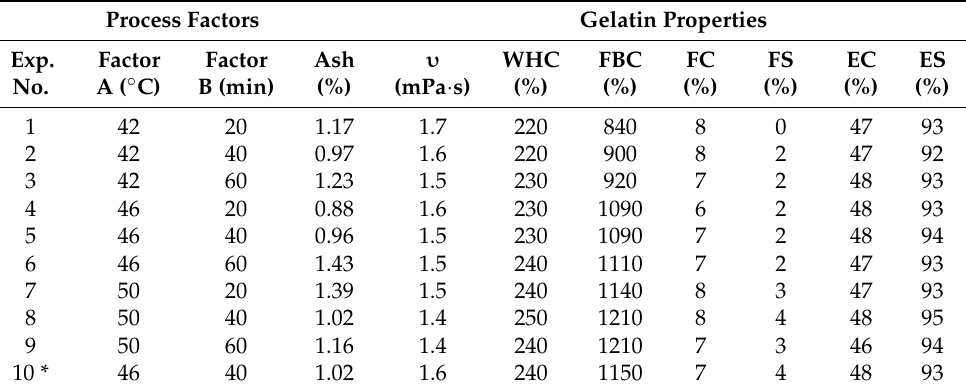
Table 3. Results of the analysis of the properties of the first gelatin fractions. Process Factors Gelatin